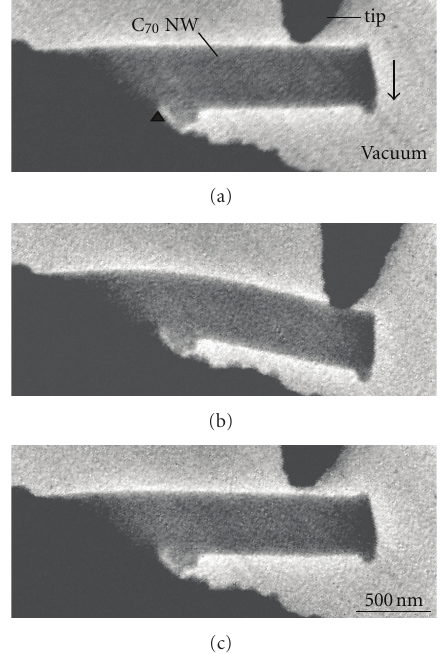
Figure 1: Time-sequence series of bright-field images of cantilever- beam-type loading, which causes bending of the C 70 single-crystal nanowhisker with outer diameter of 410nm. The left side of the nanowhisker is fixed onto a gold plate. The arrow indicates the loading direction of the cantilever tip for atomic force microscopy. The fulcrum is indicated by the triangle. This bending test was performed in the vacuum.